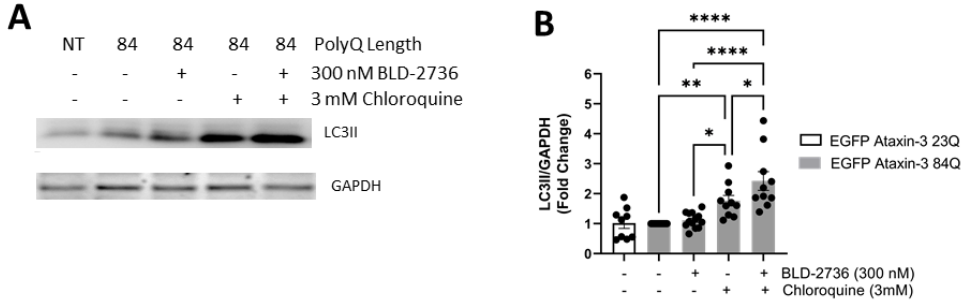
Figure 4. Treatment with BLD-2736 increased the activity of the autophagy protein quality control pathway. ( A ) Immunoblotting of LC3II revealed changes in the levels of LC3II relative to GAPDH across treatment groups. ( B ) Quantitative analysis of the ratio of LC3II to GAPDH was found to be significantly increased in larvae treated with 300 nM BLD-2736 when compared to larvae treated with the autophagy inhibitor chloroquine and 300 nM BLD-2736, indicating increased synthesis of LC3II and induction of autophagy. Protein lysates were produced from pooled samples of n = 12 – 20 zebrafish larvae. Each data point represents an independent experimental replicate. All data are presented as mean ± SEM. * represents p < 0.05, ** represents p < 0.01, **** represents p < 0.0001.